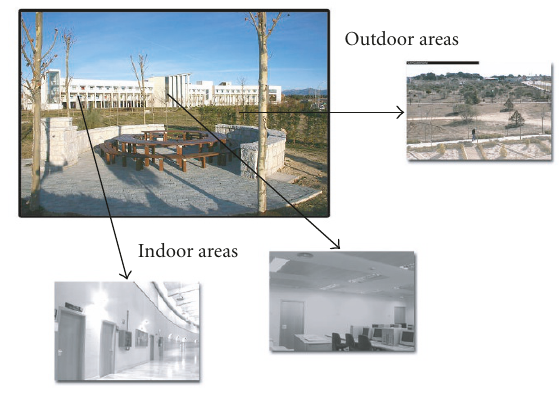
Figure 2: Several scenes captured by the cameras of our campus surveillance system. Notice that there are di ff erent areas to